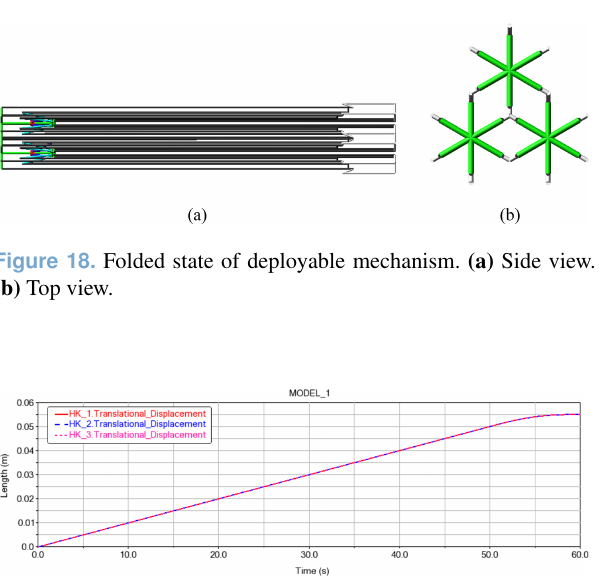
Figure 19. Displacement curves of three sliders – based on the first design scheme.